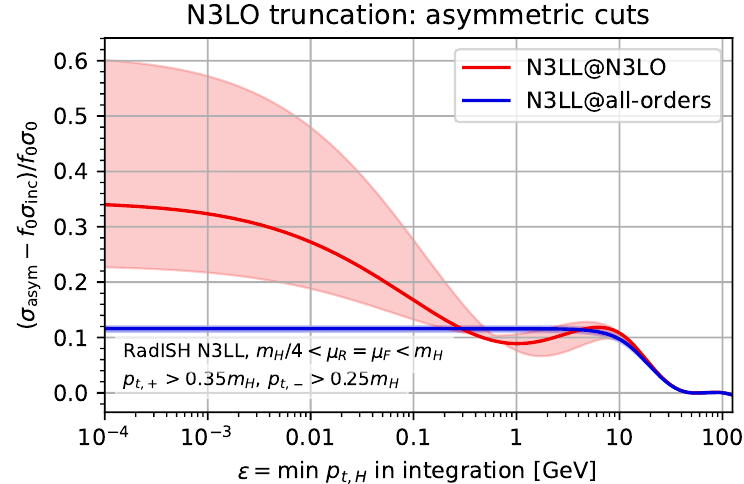
Figure 3 . The N3LL resummed result and its truncation at N3LO for the fiducial corrections to the Higgs cross section, as defined in eq. (2.22), for asymmetric p t,γ cuts, p t, + > 0 . 35 m h and p t, − > 0 . 25 m h . The results are shown as a function of (cid:15) , the minimum Higgs p t used in the integration (conceptually analogous to a technical cutoff in a projection-to-Born fixed-order calculation, cf. appendix B). The bands are the result of varying renormalisation and factorisation scales by a factor of two around m h / 2 . The N3LL distribution and expansion used to obtain these results were kindly supplied by the authors of the RadISH framework